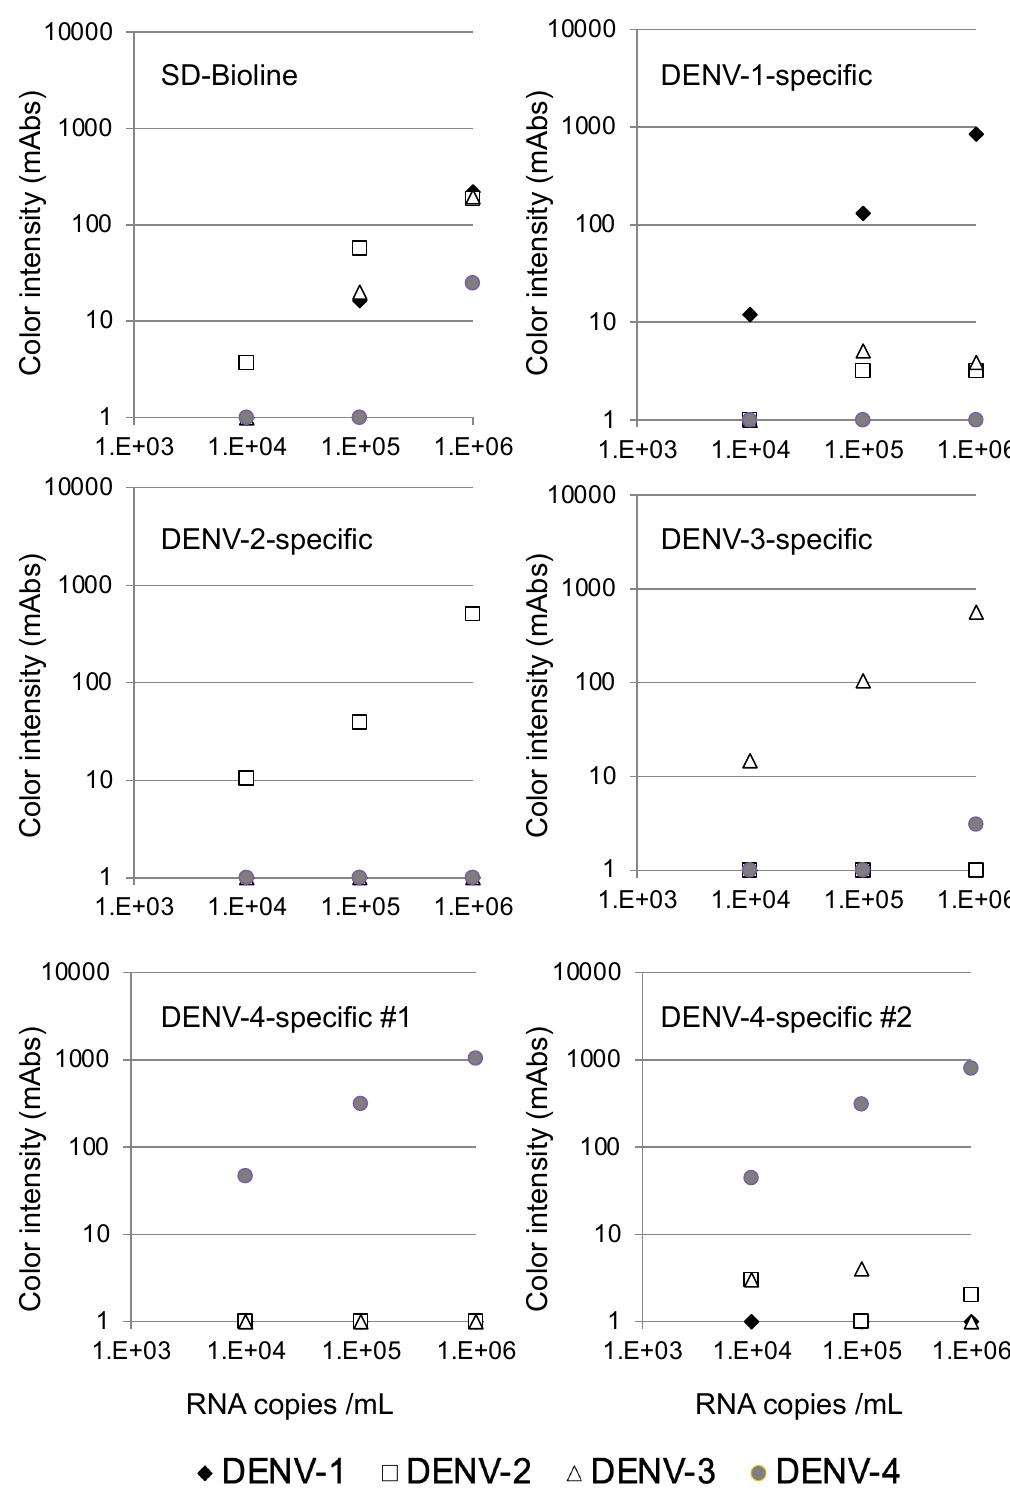
Figure 2. Evaluation of serotype specificity using laboratory strains. The limits of detection for DENV serotype-specific devices and SD Bioline were defined by chromatographing dilutions of viruses (black diamonds, Mochizuki strain of DENV-1; white squares, 16681 strain of DENV-2; white triangles, H89 strain of DENV-3; and gray circles, H241 strain of DENV-4) with known titers (10 4 , 10 5 , and 10 6 copies/mL) and then quantifying the signal color intensity (mAbs: milli-absorbance). Each of the data points represents the result of a single device.